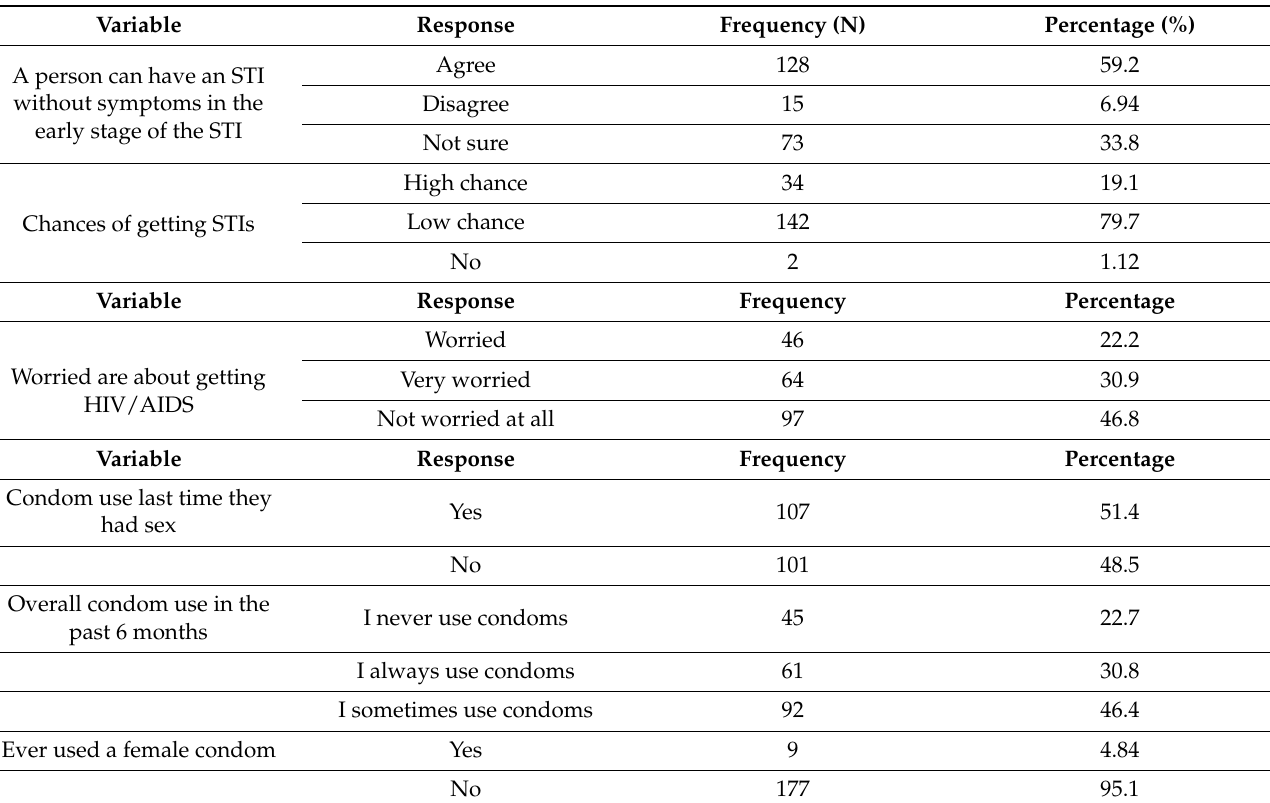
Table 9. Perceptions about STIs and condom use (n =